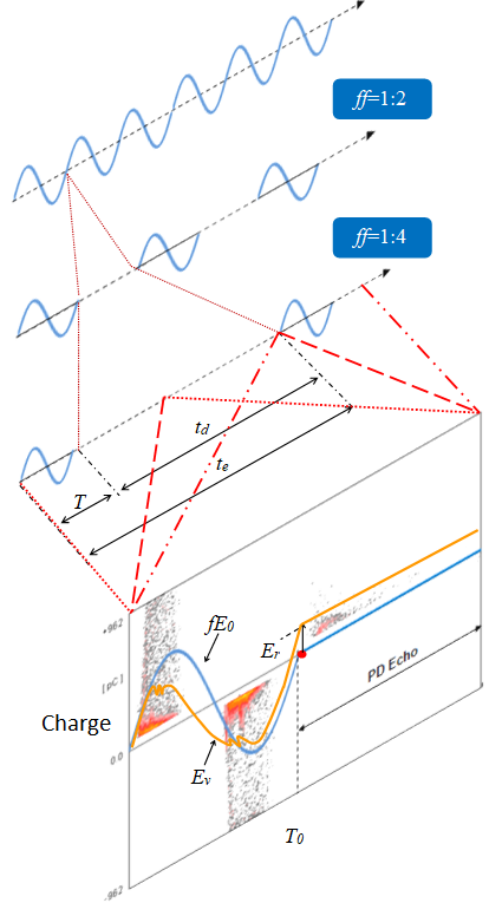
Figure 1. Illustration of a chopped partial discharge methodology, T —period of a base waveform, t d —delay time, t e —duration of the epoch, fE 0 —transposition of the external field, E r —remnant field, E v —field in the void. PD: Partial discharge.